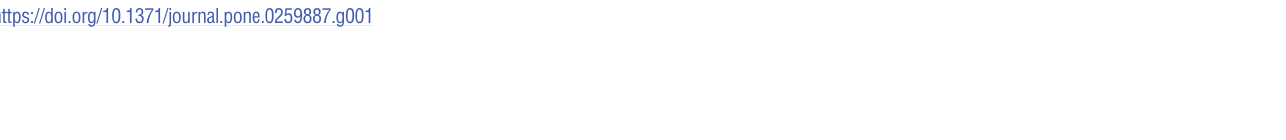
PLOS ONE | https://doi.org/10.1371/journal.pone.0259887 November18, 2021 5 /